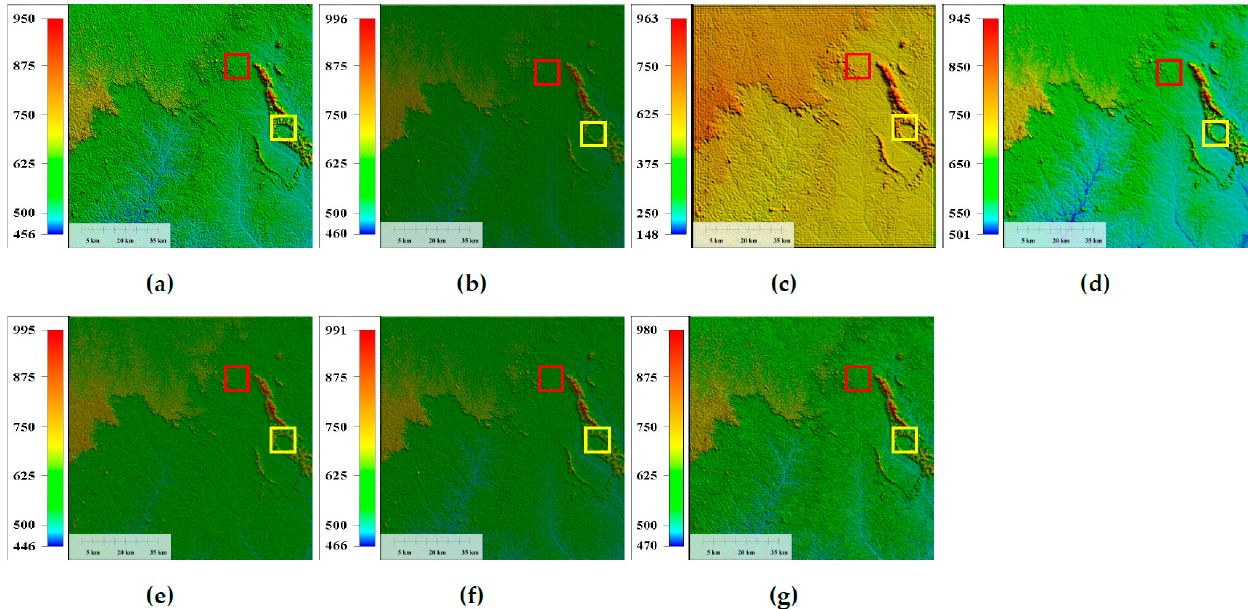
Figure 5. Results of the simulation experiment for area N01E12 with vertical stripes and random-noise mixing errors (unit: meter). ( a ) Original N01E12 area (PSNR, SSIM), ( b ) mixed error (30.01, 0.5511) added, ( c ) low-pass filter (29.19, 0.4322), ( d ) total variation (TV) (30.76, 0.5460), ( e ) Unidirectional Total Variation (UTV) (29.95, 0.5179), ( f ) Low-Rank based Single-Image Decomposition (LRSID) (30.48, 0.6617) and ( g ) low rank group-sparse method (LRGS) (30.94, 0.8319).